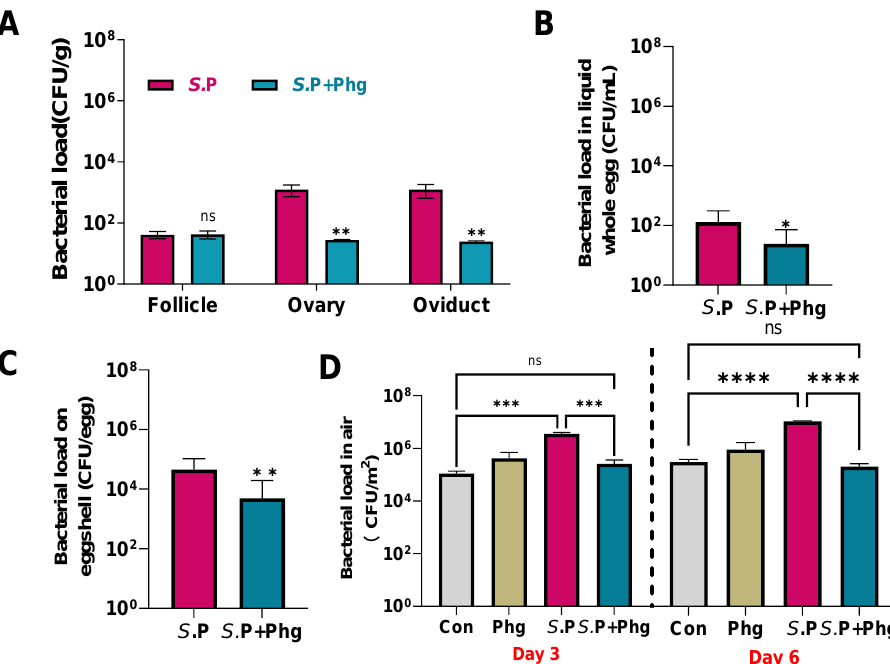
Figure 6. Phage CKT1 controlled the vertical transmission of S. Pullorum. ( A ) S. Pullorum load in tissues at 6 d. n = 5. ( B ) S. Pullorum load in liquid whole eggs at 2–6 d. n = 11 at S .P and n = 10 at S. P + Phg. ( C ) S. Pullorum load on eggshell at 2–6 d. n = 11 in S. P group and n = 10 in S. P + Phg group. * p < 0.05 (Mann–Whitney test); ** p < 0.01; ns, no significance. ( D ) Bacterial load in the air at day 3 and day 6. n = 3. Error bars represent the standard deviations. *** p < 0.001 (One-way ANOVA and post hoc Tukey’s test); **** p < 0.0001; ns, no significance. S. P, only Salmonella challenged; Con, the control group; Phg, only phage treated; S. P + Phg, Salmonella challenged and phage treated.